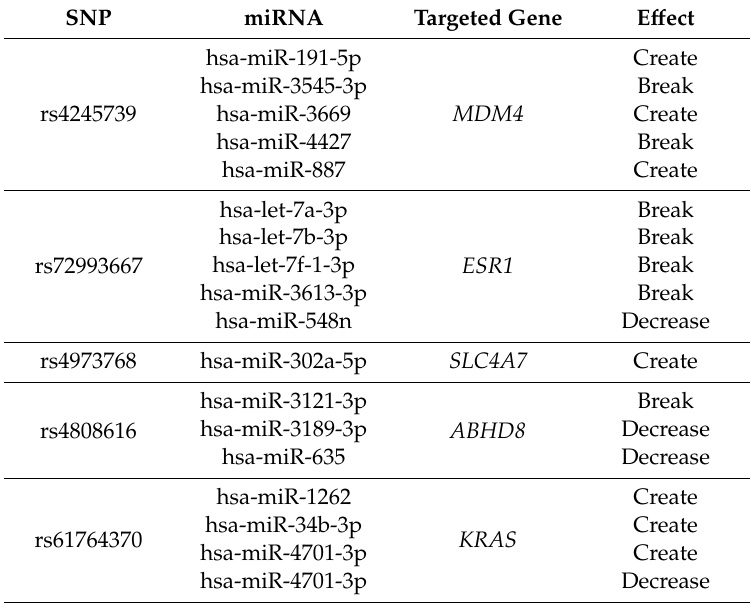
Table 1. Single nucleotide polymorphisms (SNPs) associated with predicted miRNA target